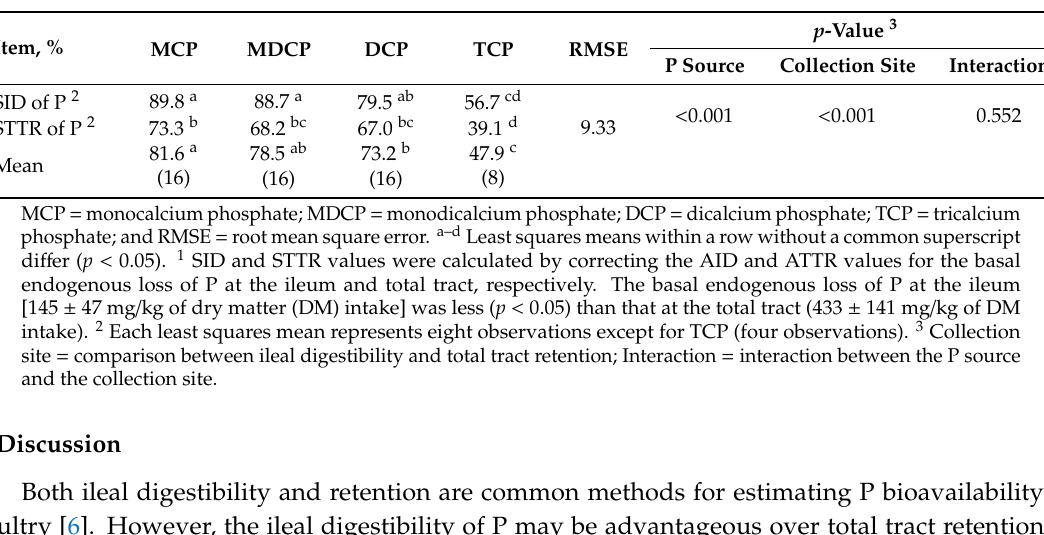
Table 5. Standardized ileal digestibility (SID) and standardized total tract retention (STTR) of phosphorus (P) in inorganic phosphates fed to broiler chickens 1